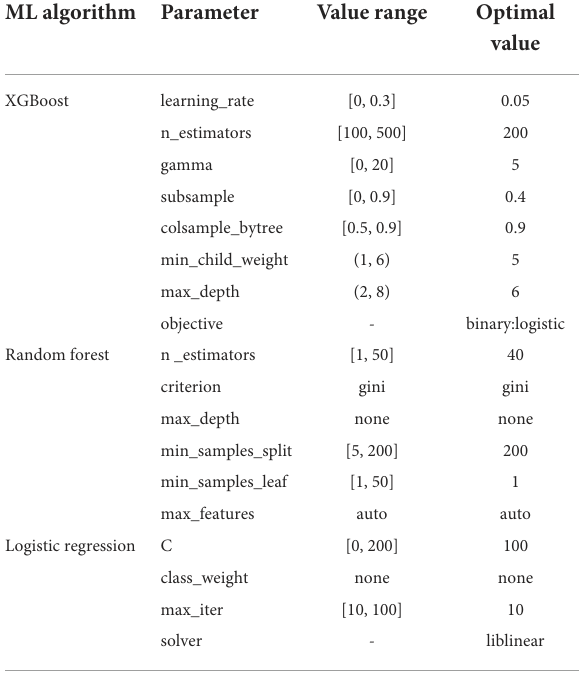
TABLE 2 Configuration of parameters in each ML algorithm. ML algorithm